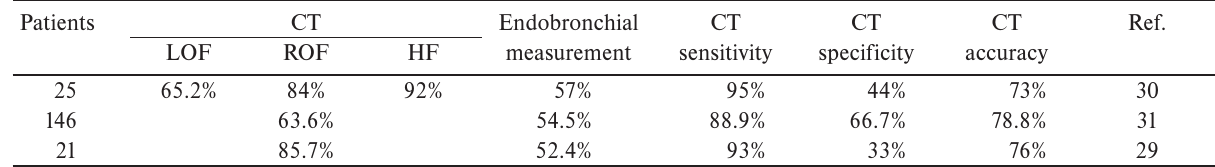
Table 3. Frequencies of incomplete fissures, comparison of CT and endobronchial